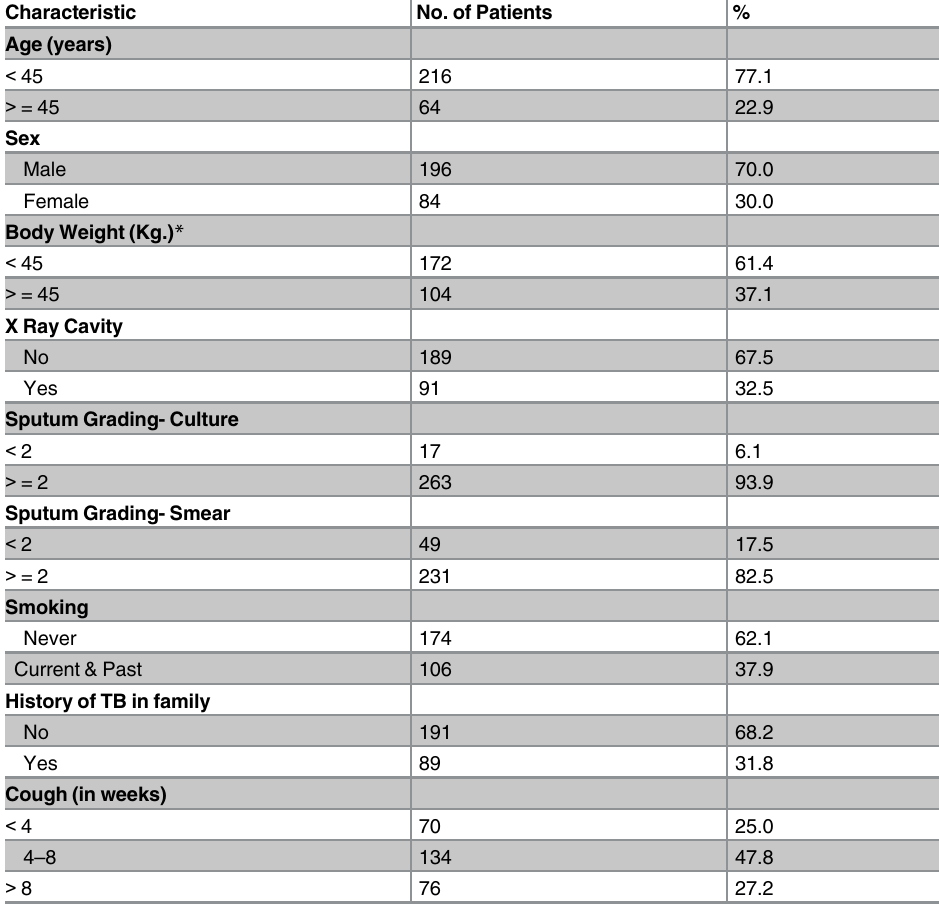
Table 1. Socio-demographic and clinical characteristics of new sputum smear positive index cases (N = 280) in Chennai, India.